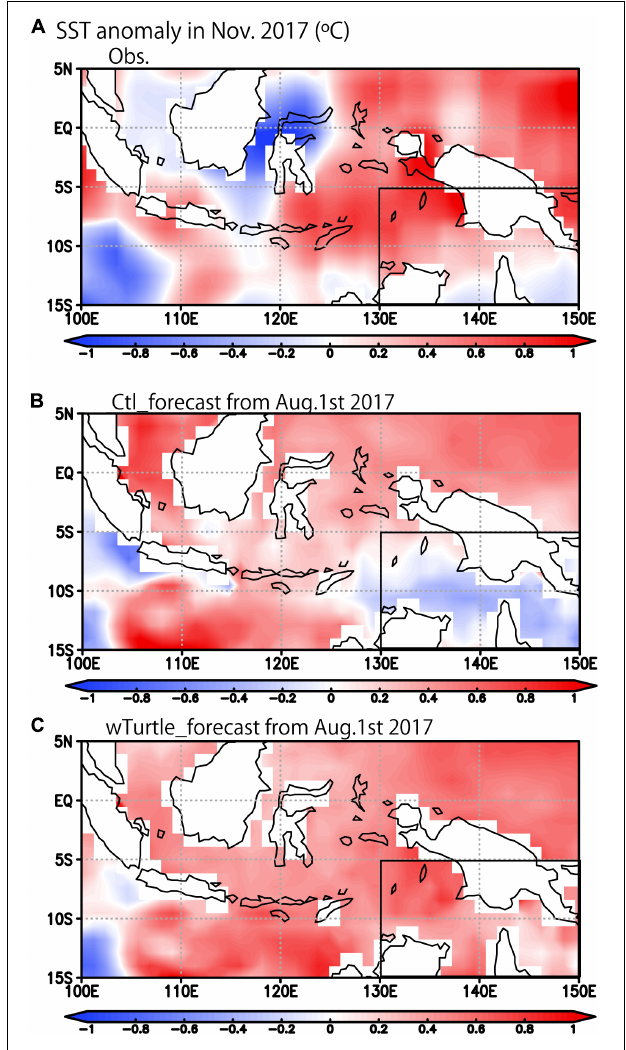
FIGURE 5 | SST anomaly in November 2017 from (A) the observations, (B) the Ctl_forecast, and (C) the wTurtle_forecast issued on August 1, 2017 ( ◦ C). The region for Figure 6 is shown by a black